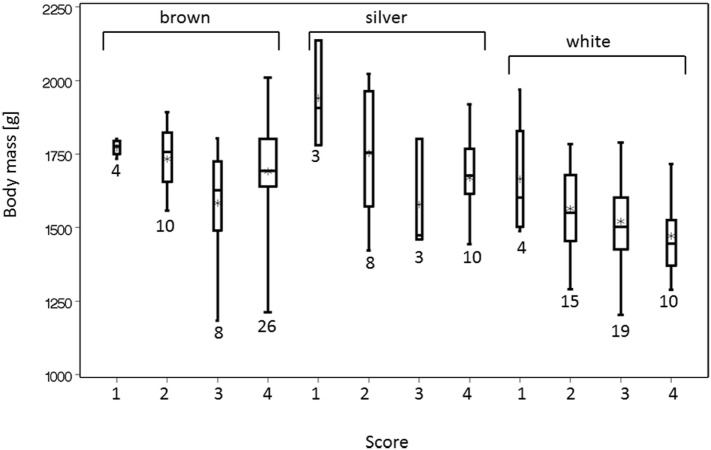
Body mass after slaughter was associated with the score of the keel bone. Score 4 indicates an intact keel bone, score 3 indicates a slightly deformed keel bone, and scores 2 and 1 (=worst) indicate fractured keel bones. The width of the box plots indicates the sample size, and the numbers of animals are beneath the bars.